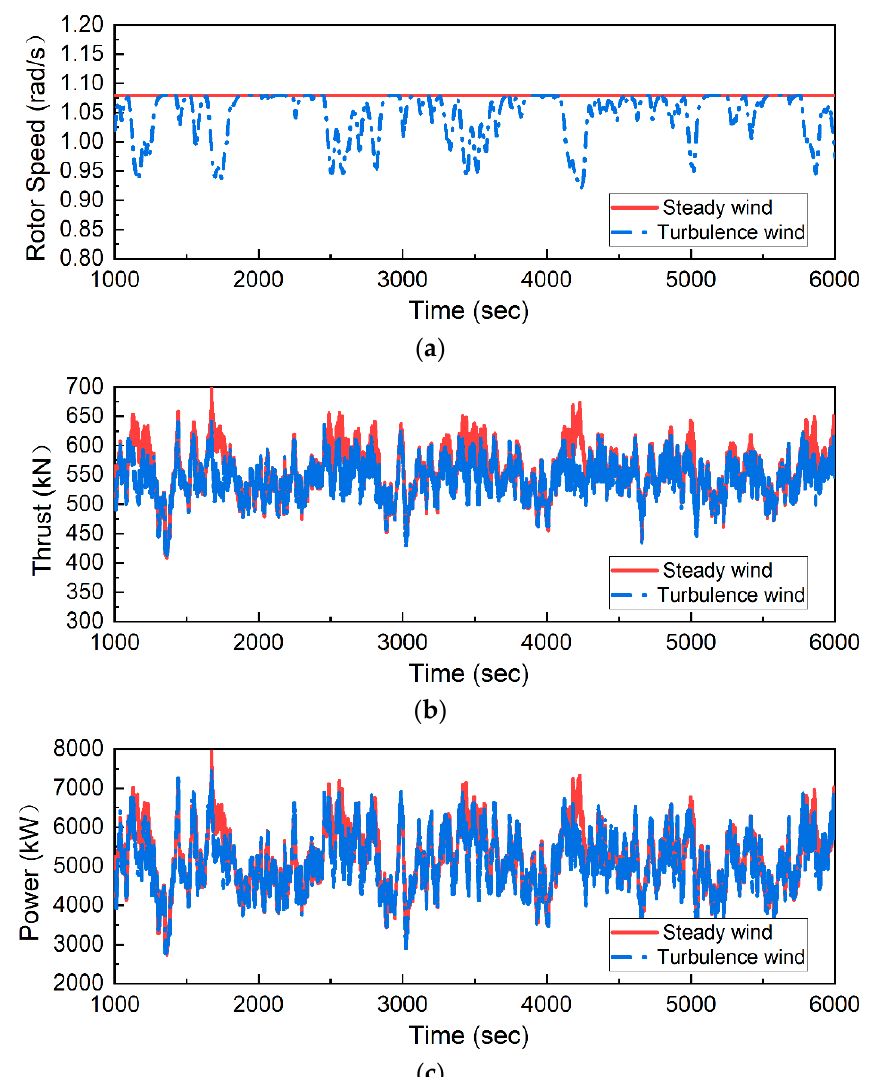
Figure 11. Aerodynamic performance of the case when the average wind speed is 14 m/s. ( a ) Rotor speed; ( b ) Thrust; ( c ) Output power.